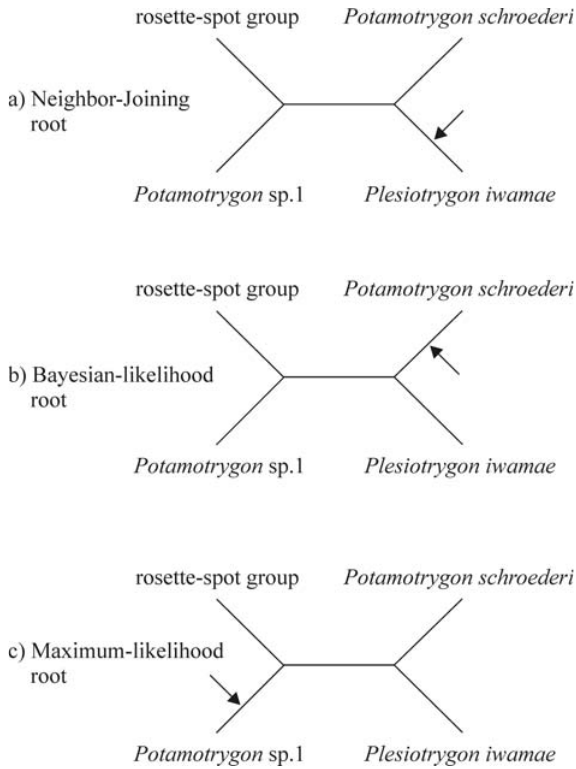
Figure 4 - Schematic representation of the ingroup topology which is re- covered by all three methods of phylogenetic inference. Arrows represent rooting points of the different analyses: a) Neighbor-joining root; b) Bay-